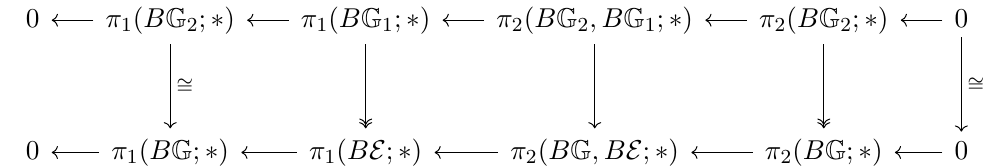
Figure 26 . The upper row and the lower row are pieces of long exact sequences of homotopy groups for pointed pairs ( B G G ) and ( B G , B E ) , respectively. Downwards arrows are induced 2 , B 1 by the inclusion